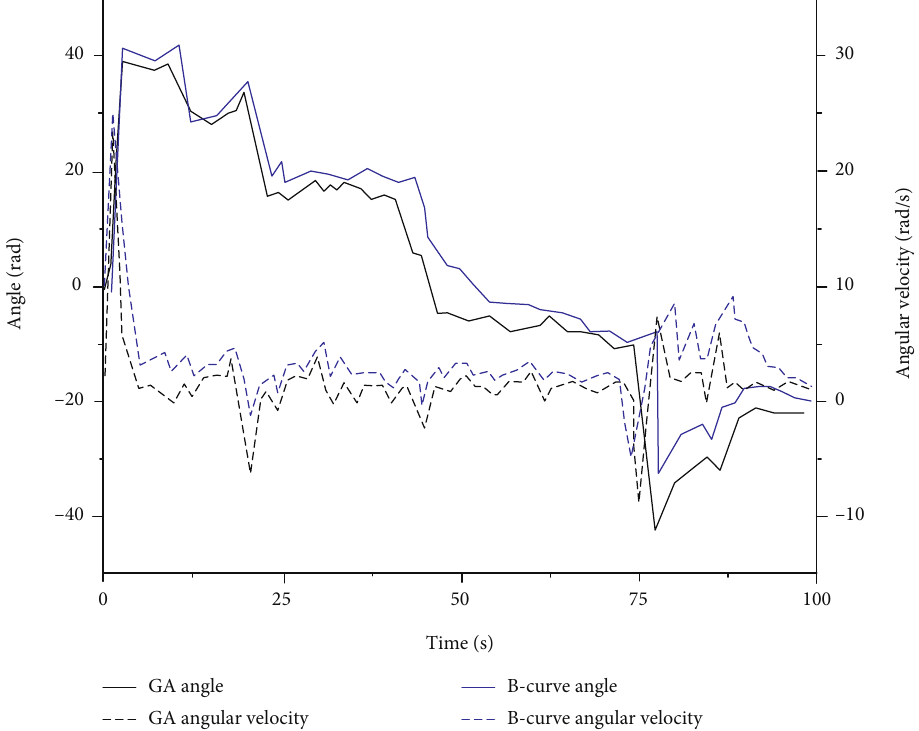
Figure 8: Comparison of robot angle and angular velocity between single B-spline curve method and fusion genetic algorithm.